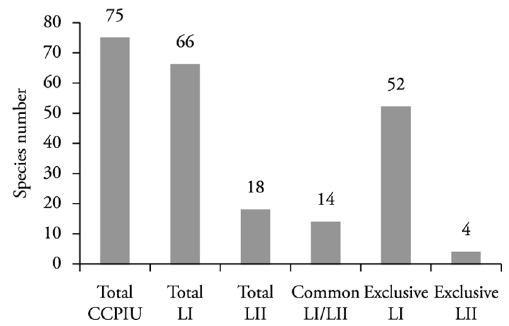
Figure 5. Total, common and exclusive zooplankton species number sampled from each lake in Clube Caça e Pesca Itororó de Uberlândia, Minas Gerais (2006). LI: lake overgrown by macrophytes; LII: open Table 2. Shannon-Wiener’s Diversity ( H’ ), Simpson’s Diversity ( D’ ) and Evenness ( J ) calculated for zooplankton community of the Lakes I and II of Clube Caça e Pesca Itororó de Uberlândia, Minas Gerais (2006). H’